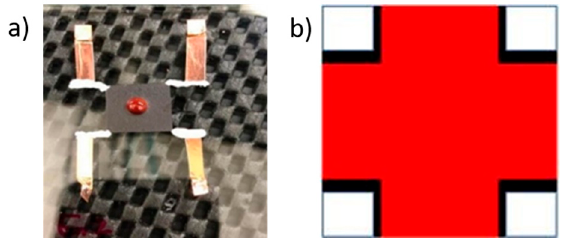
Figure 11. Buckypaper is connected to copper tape using silver paint. ( a ) The BP has three fused drops of red enamel in the center that were spread in a cross pattern ( b ).